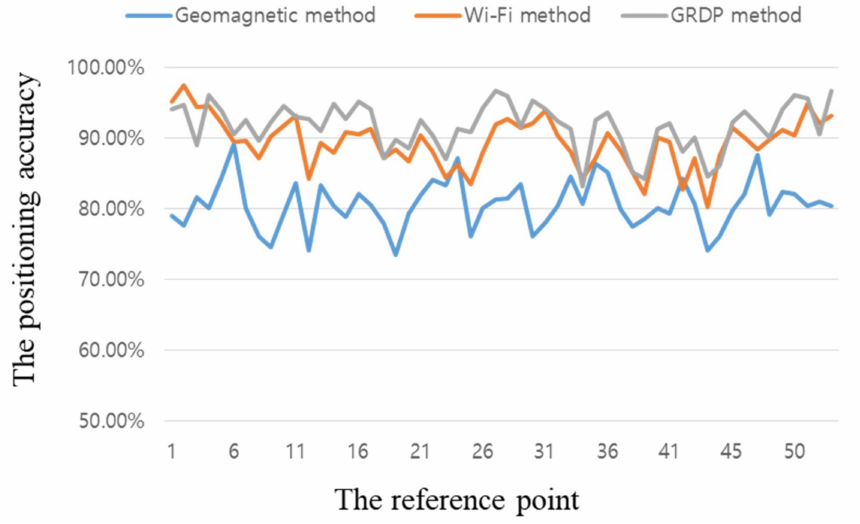
Figure 10. Positioning accuracy according to the proposed algorithm’s reference